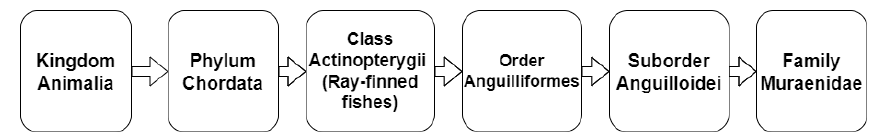
Figure 1. The m oray eel’s biological classification tree . Figure 1. The moray eel’s biological classification